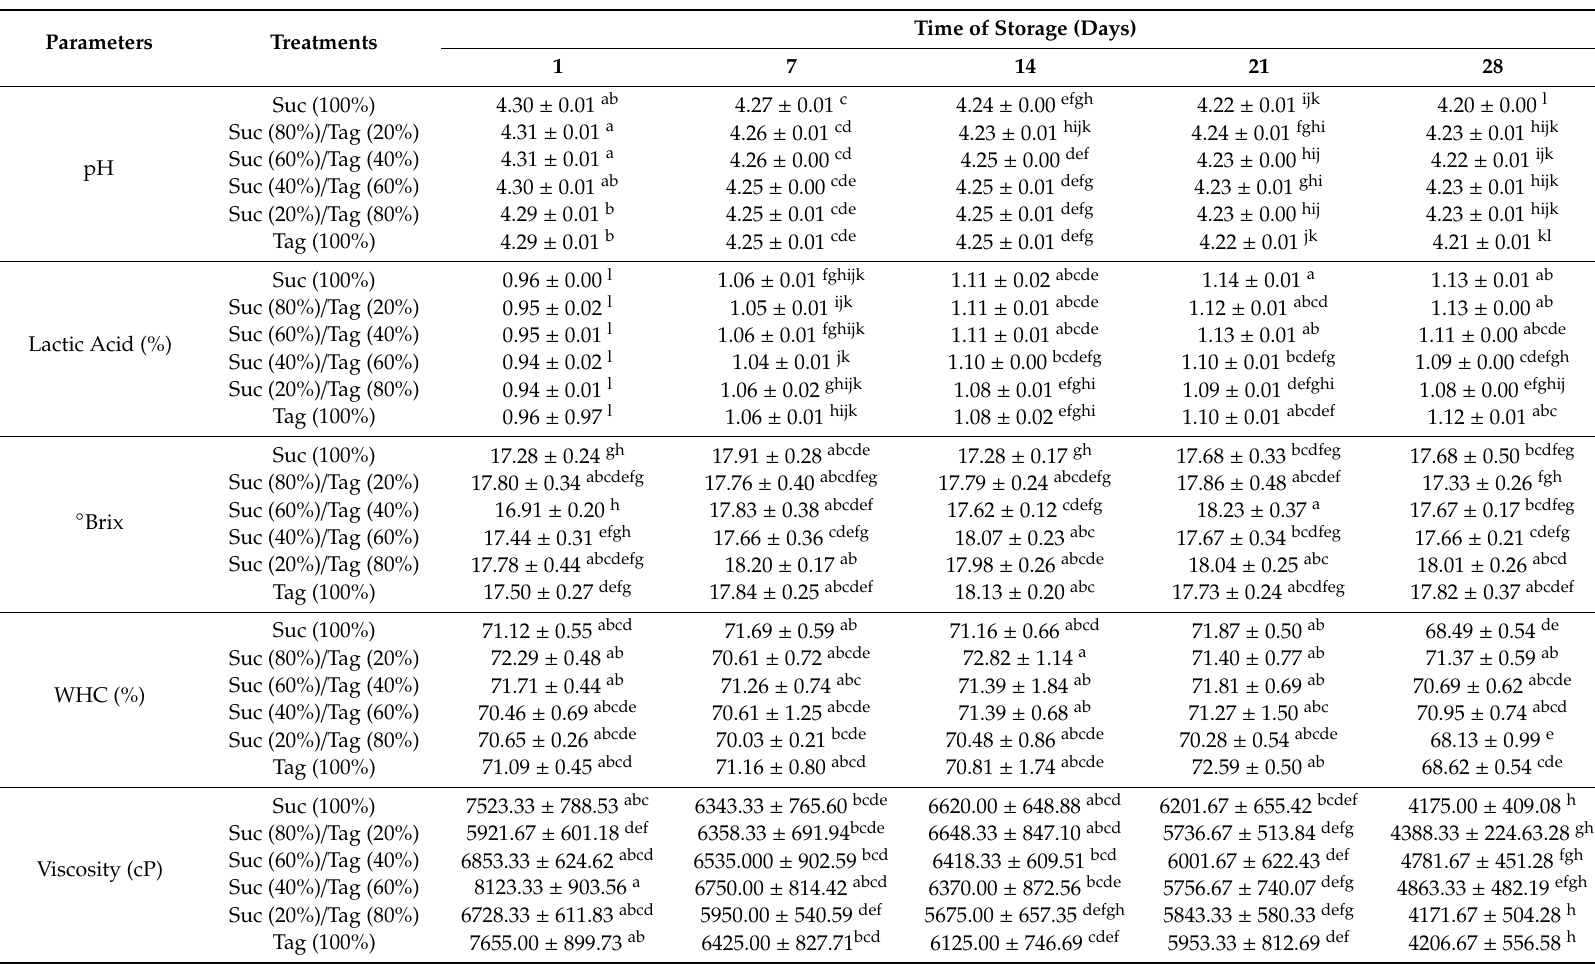
Table 2. E ff ects of tagatose substitutions on pH, lactic acid (%), ◦ Brix, water holding capacity (WHC), and viscosity of yogurt samples during 28 days of storage at 4 ◦ C.